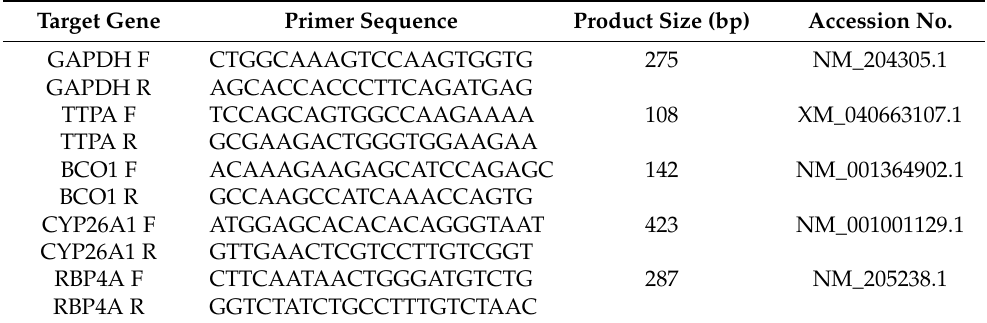
Table 2. The forward and reverse of primer sequence, product size, accession number of target genes.